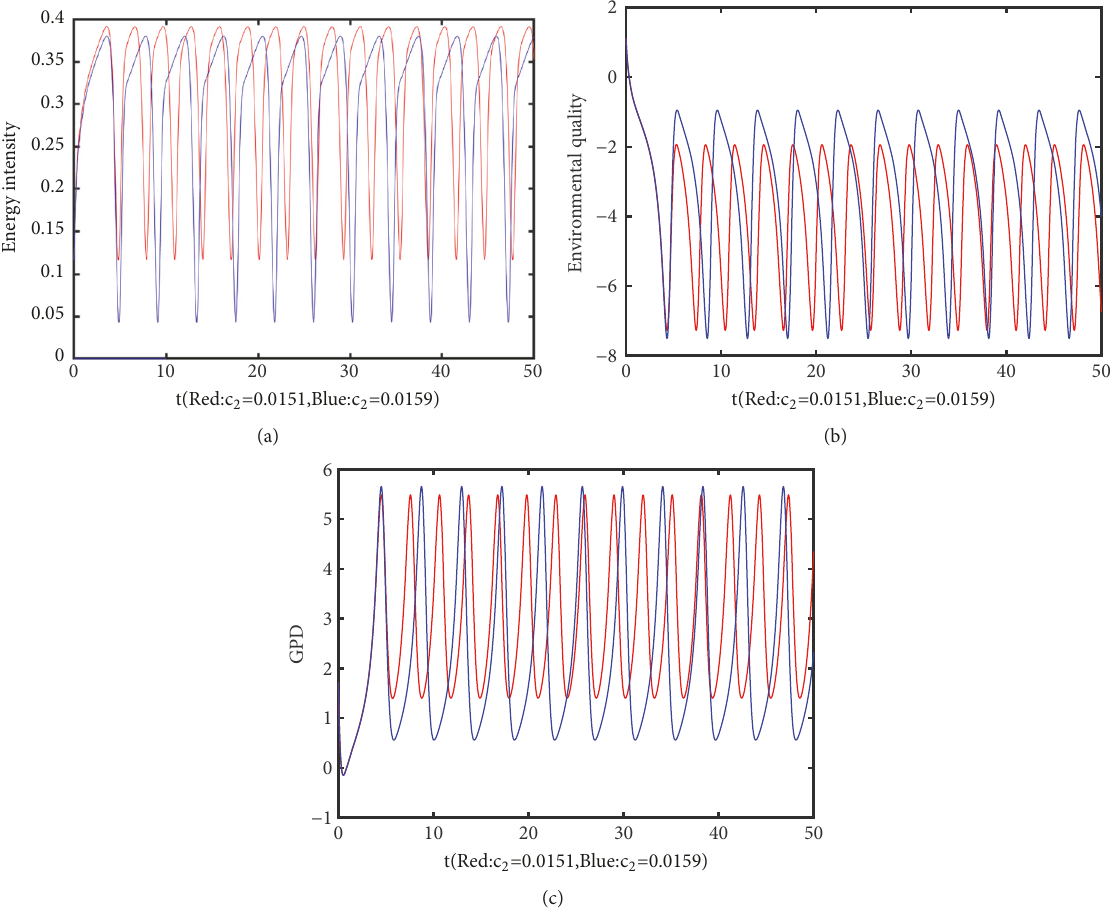
Figure 8: The influence of system (1) parameters 𝑐 2 on energy intensity and environmental quality: (a) energy intensity, (b) environmental quality, and (c)